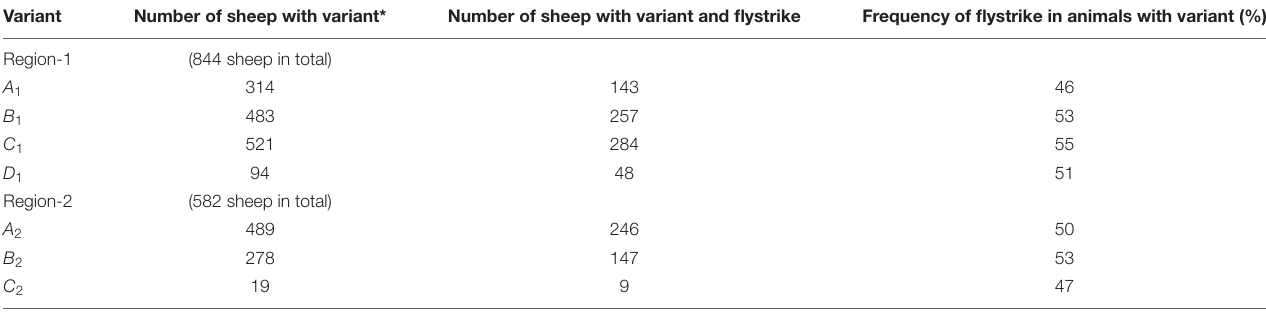
TABLE 1 | Frequencies of flystrike in sheep with FABP4 Region-1 and Region-2 variants. Variant Number of sheep with variant*